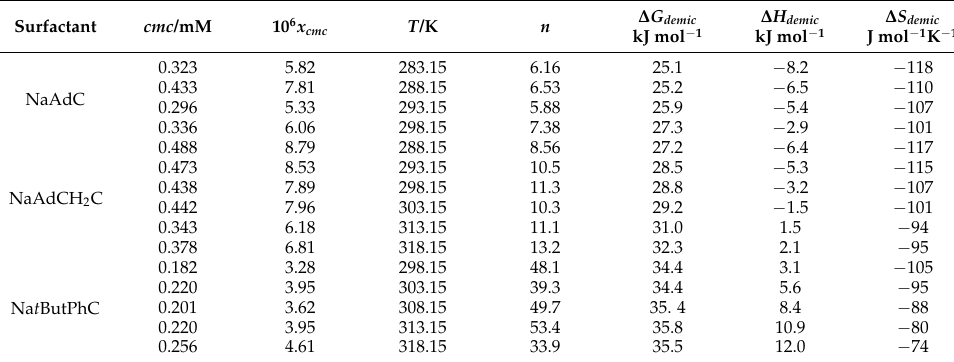
Figure 5. Determination of the aggregation number according to Equation (2). Concentration of injected NaAdCH 2 C 10.17 mM; total buffer concentration 50.60 mM, pH 10.35. T 45 °C. Table 1. Critical micelle concentration (expressed as molar concentration, cmc , and mole fraction, x cmc ), aggregation number, n , and thermodynamic parameters for the demicellization of the indicated surfactants at different temperatures.